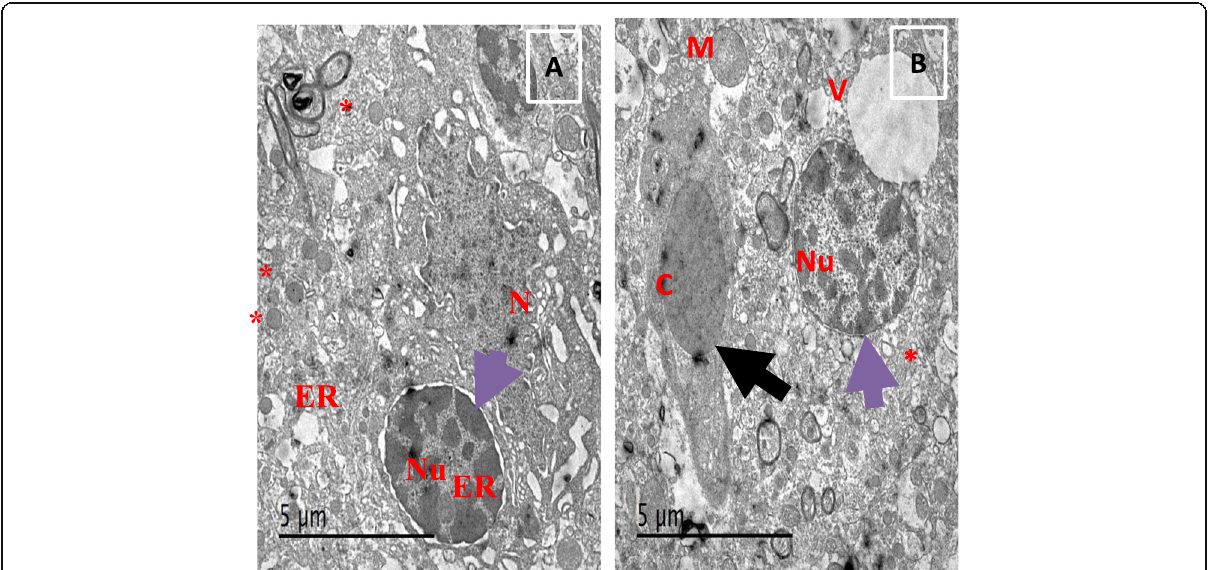
Fig. 8 Transmission electron microscope of brain section in ASP-LD and ASP-HD with LC groups. a TEM of group treated with combination of ASP-LD and LC showing amelioration in the cytoplasmic organelles as the nucleus (Nu) return to its rounded normal shape with normal nuclear membrane (head arrow) with homogenous distribution of chromatin, appearance of endoplasmic reticulum and small mitochondria (*), and appearance of normal neurons (N). b TEM of group treated with combination of ASP (HD) and LC showing restoration of normal shape of the nuclei (N) with nuclear envelope (head arrow), The capillary (C) become very constricted and decreasing the hemorrhage area with appearance of tight junction with some enlargement but without edema (black arrow), normal sized mitochondria (M) but with some large vacuoles